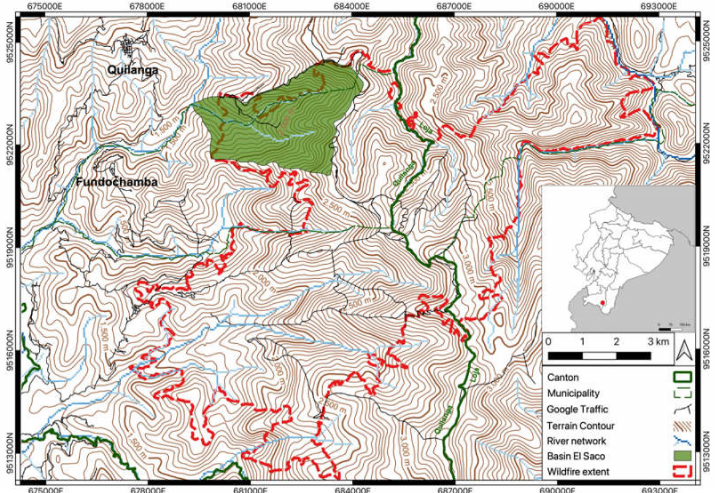
Figure 1. Location and extent of the wildfire area (red), as well as the river El Saco basin (green) in Quilanga, Ecuador; Background: contour map of elevation and river network derived from DEMs (credit: Marc Souris, IRD), Road network: Google